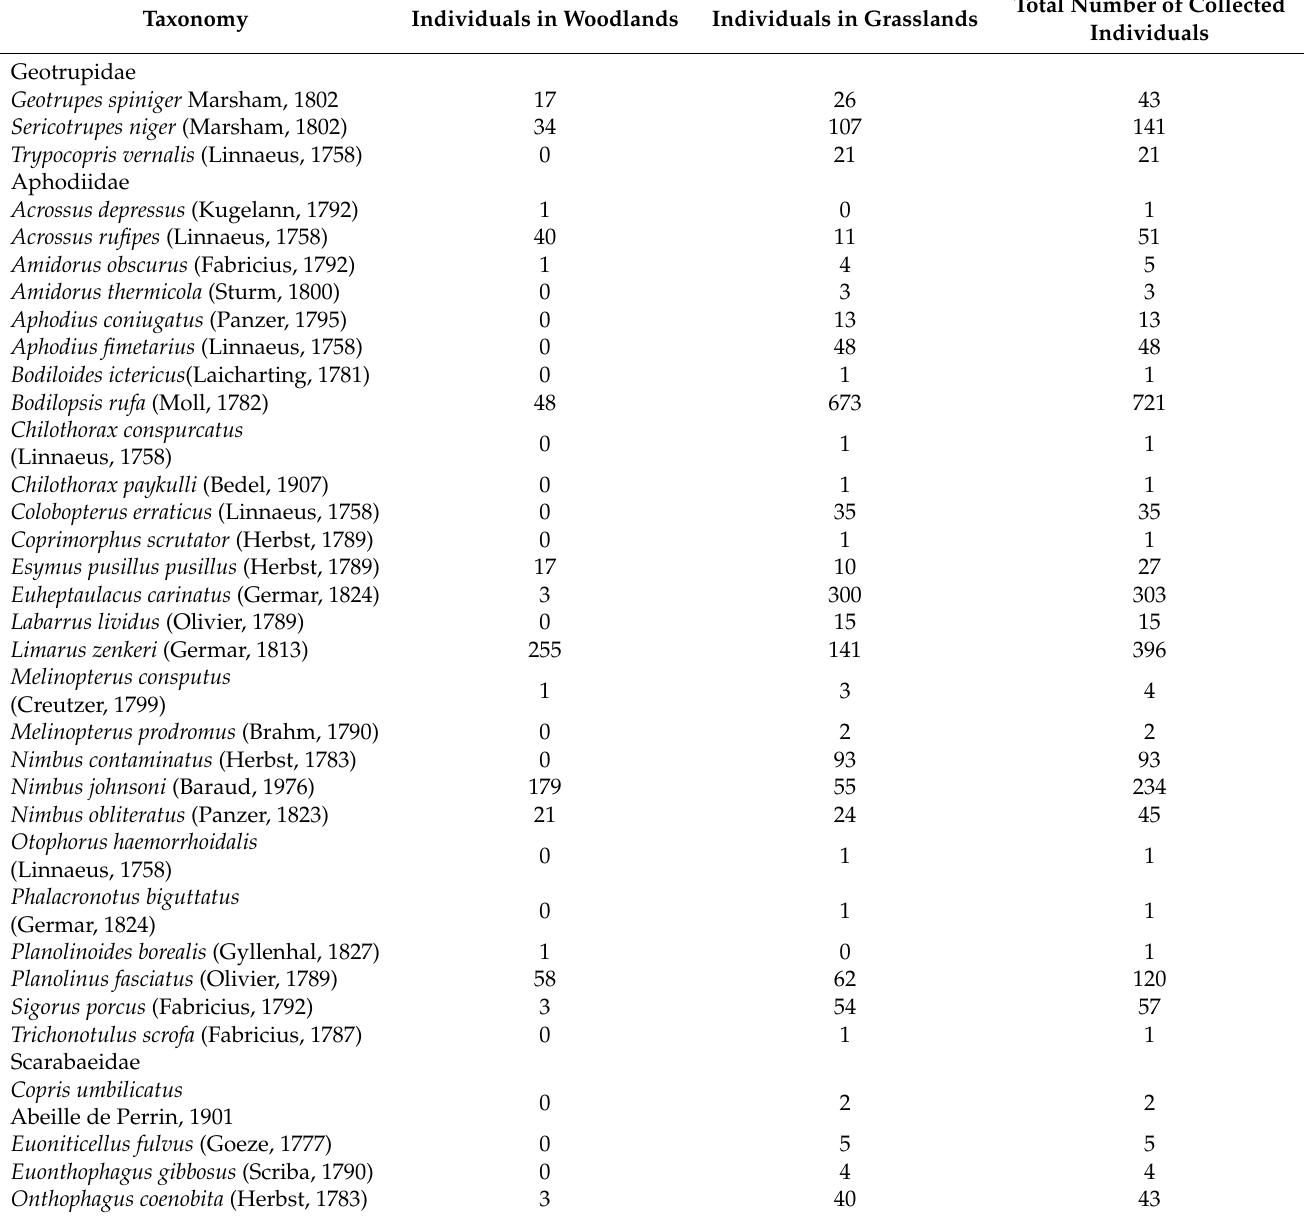
Table 1. Number of individuals captured for each species of dung beetle collected along an elevational gradient in central Italy. Individuals in Woodlands Individuals in Grasslands